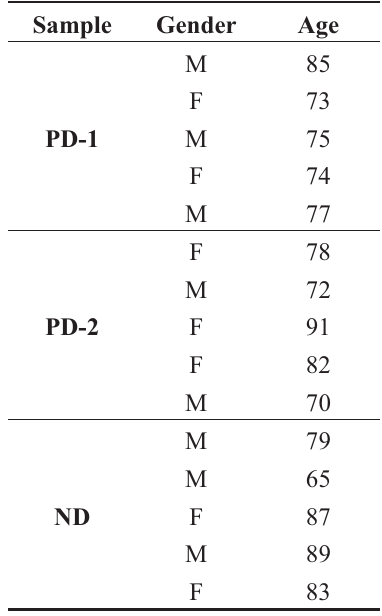
Table 1. Human Brain Samples for Parkinson’s Disease PD-1, PD-2 and